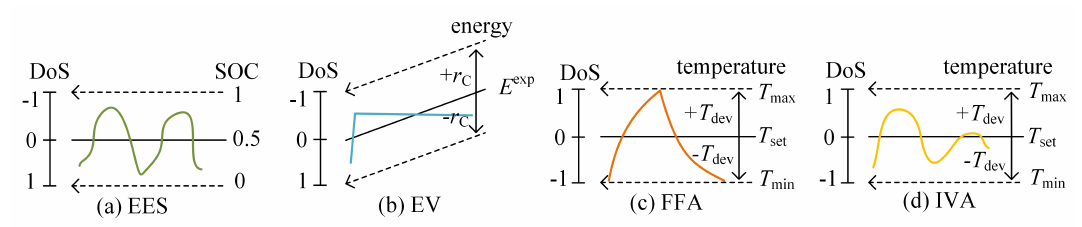
Figure 1. The degree of satisfaction (DoS) of different generalized energy storages